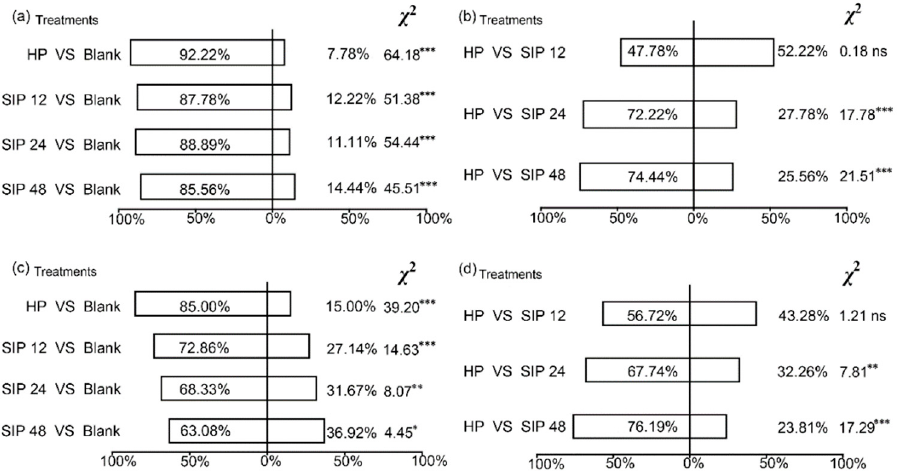
Figure 2. Percentage of S. litura attracted to no plants (blank), healthy Chinese cabbage plants (HP), plants infested with S. litura (SIP; for 12, 24, or 48 h) in S. litura Petri dish experiments 1 ( a ) and 2 ( b ) and in S. litura olfactometer experiments 1 ( c ) and 2 ( d ). *, **, ***, and ns indicate p < 0.05, <0.01, <0.001, and not significant, respectively, according to a χ 2 test.